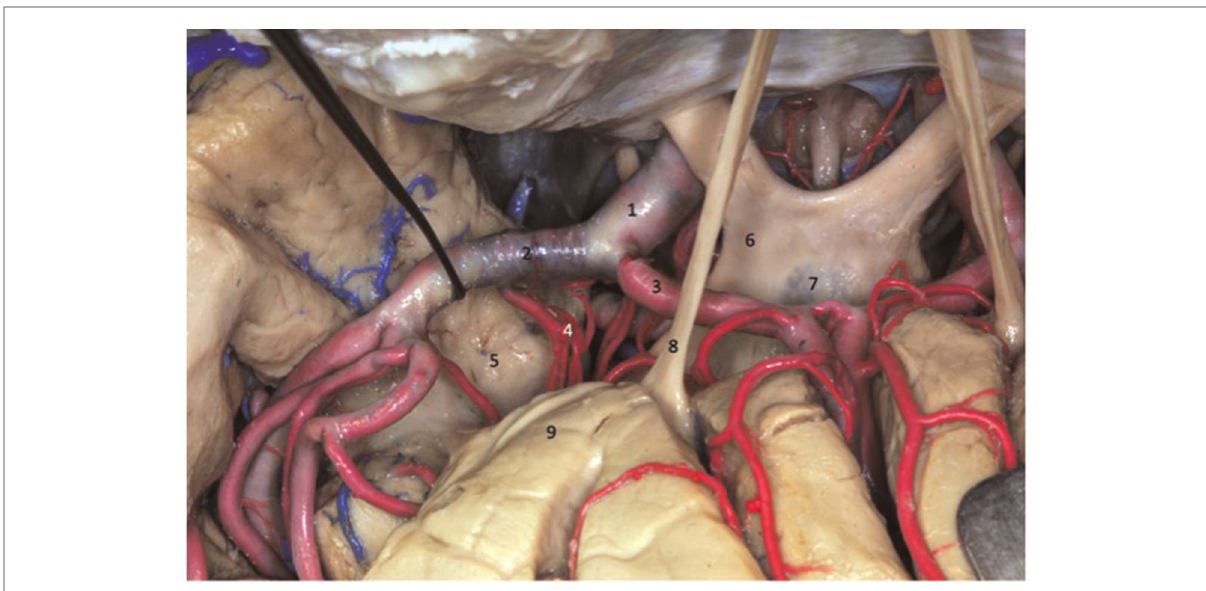
FIGURE 7 Superior view of the dissected sylvian fi ssure that shows the arteries that supply the insula. The dissector is laterally displacing the MCA to expose the lenticulostriate arteries (4). 1 - internal carotid artery; 2 - middle cerebral artery; 3 - anterior cerebral artery;4 - lenticulostriate arteries; 5 - uncus; 6 - optic chiasm; 7 - lamina terminalis; 8 - olfactory tract; 9 - frontal lobe.